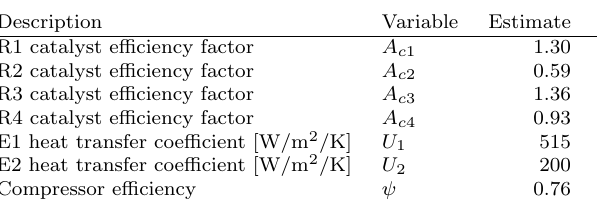
Table 6: Estimates of unmeasured variables for data set no. 12